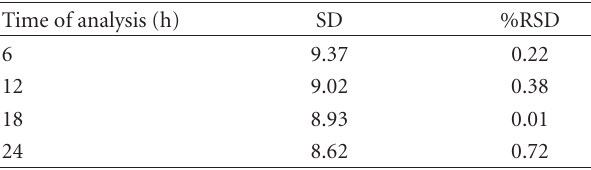
Table 3: Stability of drug in sample solution a .